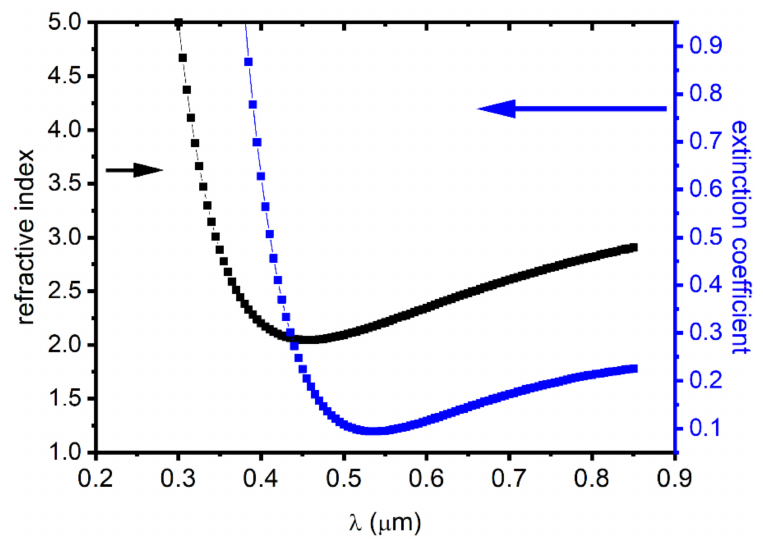
Figure 7. The extinction coefficient and refractive index variations as a function of the